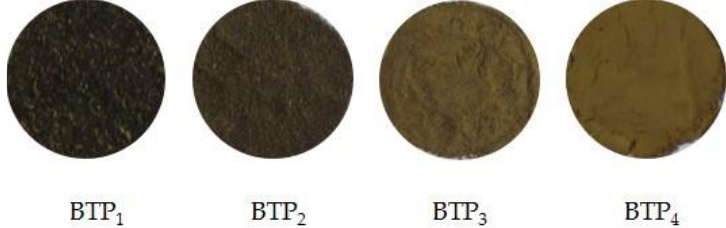
Figure 1. Black tea powders passed through a 1.00 mm screen (BTP 1 ); black tea powders passed through a 0.50 mm screen (BTP 2 ); black tea powders passed through a 0.25 mm screen (BTP 3 ); and black tea powders ball-milled for 8 h (BTP 4